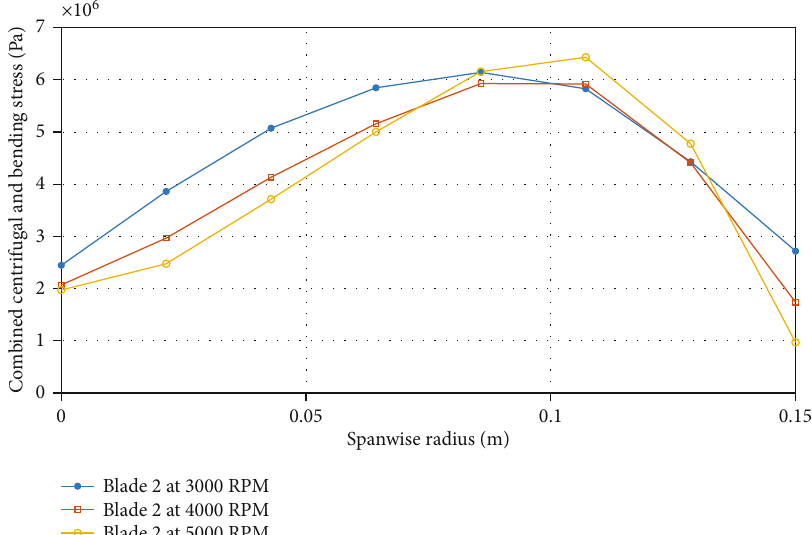
Figure 9: Combined stress developed in the blade.